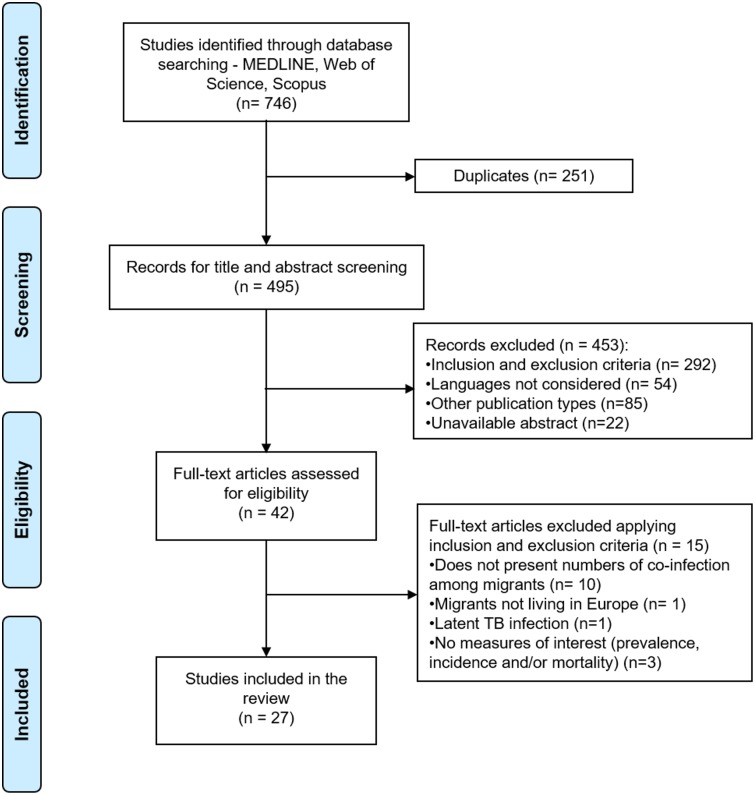
PRISMA flow diagram.